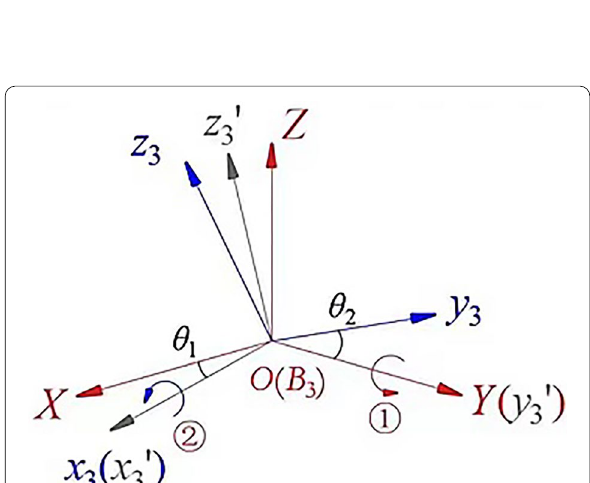
Figure 3 Coordinate system B 3 - x 3 y 3 z 3 Euler